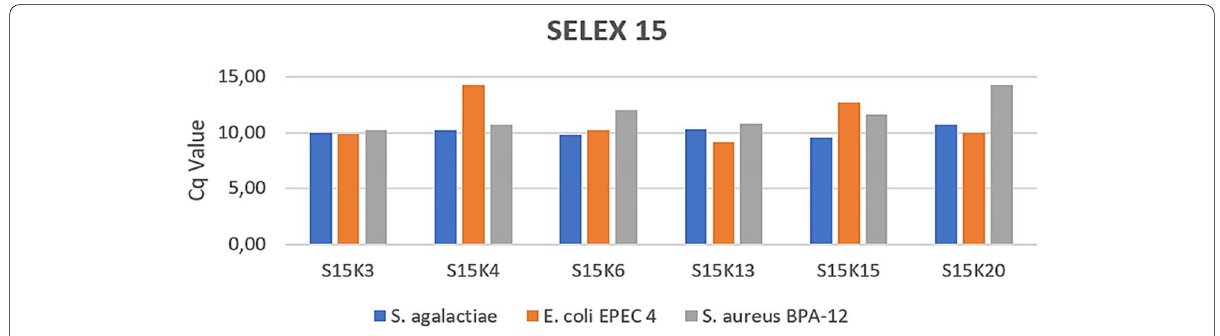
Fig. 5 The binding capacity of the selected